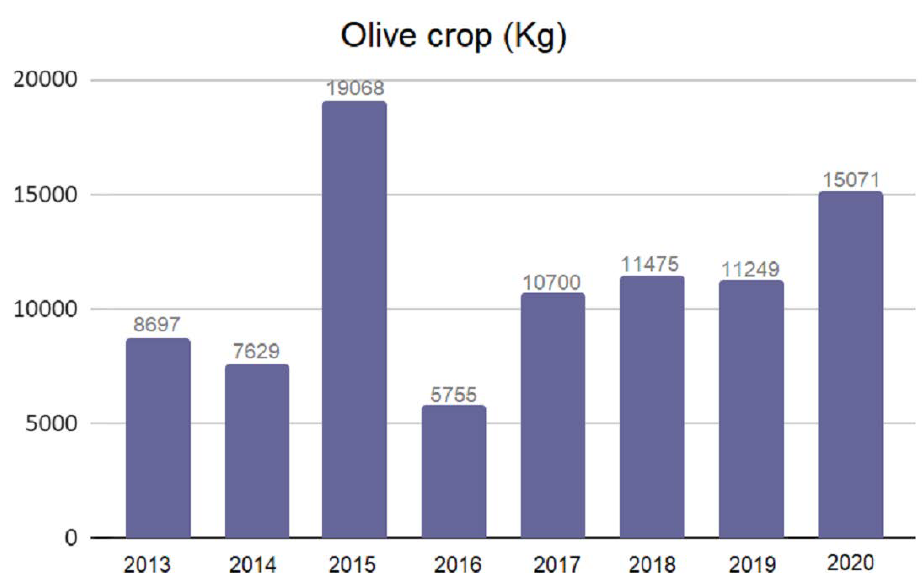
Figure 7 . Example of anomaly detection. Figure 7. Example of anomaly detection.